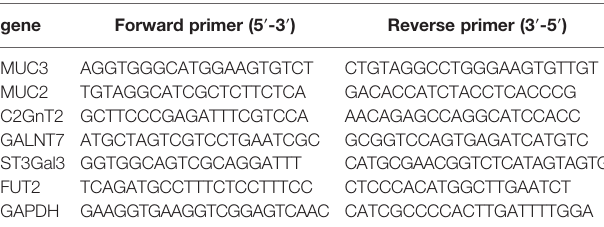
TABLE 1 | Primers used for qRT-PCR. gene Forward primer (5 ′ -3 ′ )